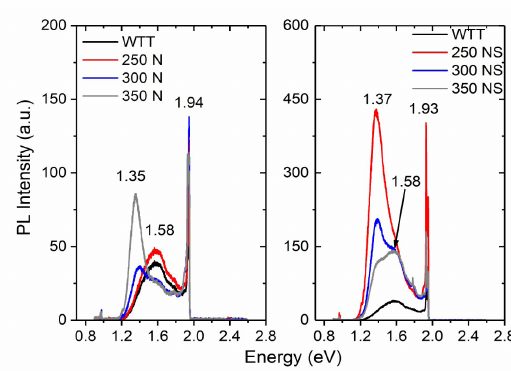
Figure 5. UV-Vis spectra of the film annealed at room temperature and five temperatures: a) In a nitrogen atmosphere, b) in a nitrogen- sulfur atmosphere and c) Direct Band gap as a function of the temperature and atmospheres.